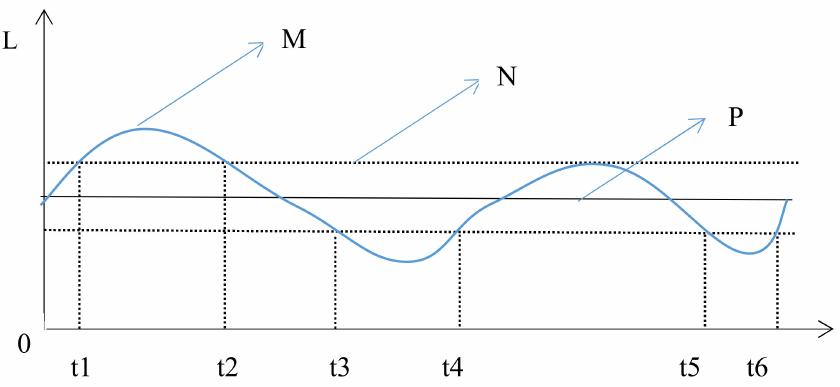
Figure 1. Service capacity curve of a logistics unit.